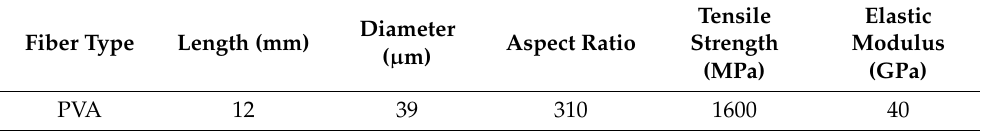
Table 1. Properties of the PVA fibers.